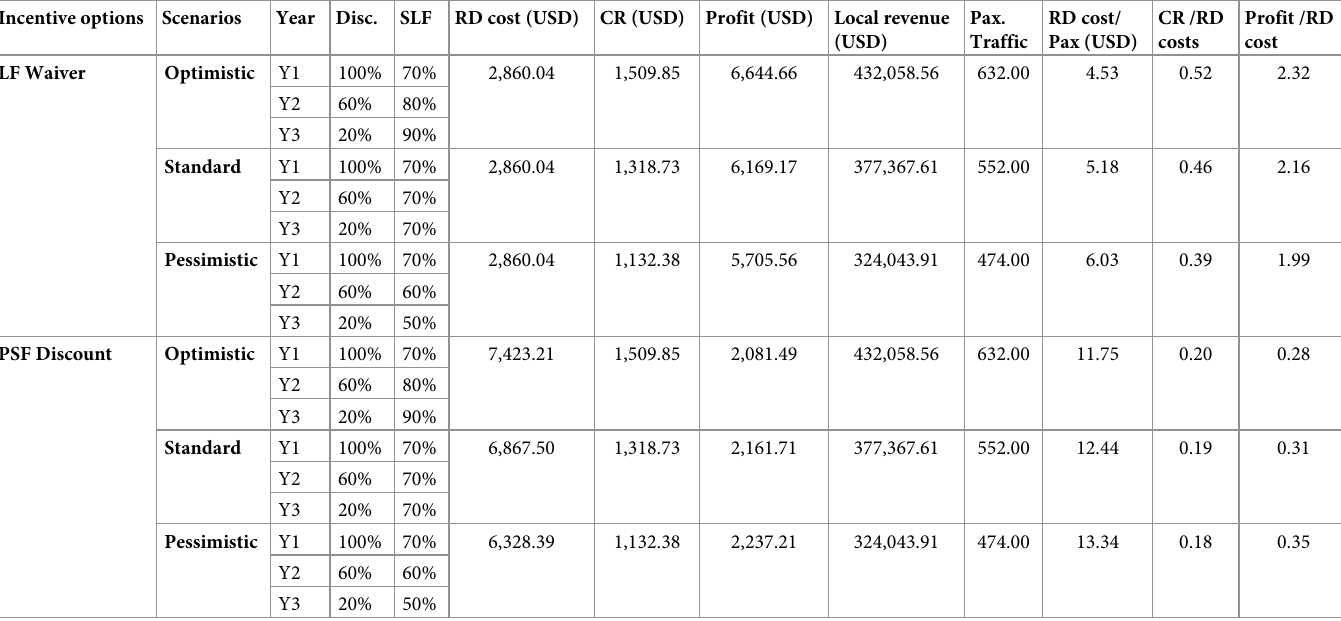
Table 4. Results for the standard, optimistic, and pessimistic scenarios. Incentive options